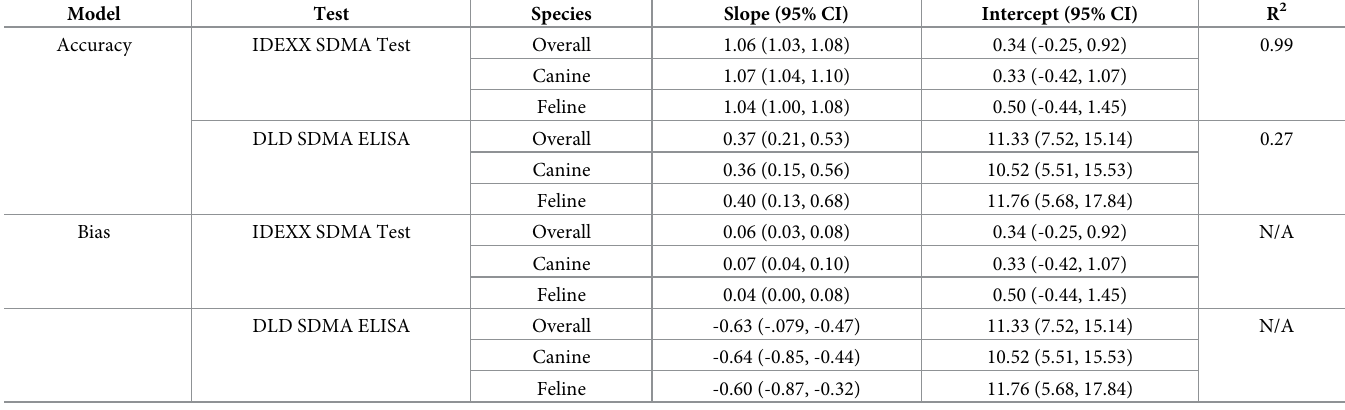
Table 1. Slopes and intercepts with 95% confidence intervals for the best fit linear models determined for all samples and for canine and feline samples individually. Model